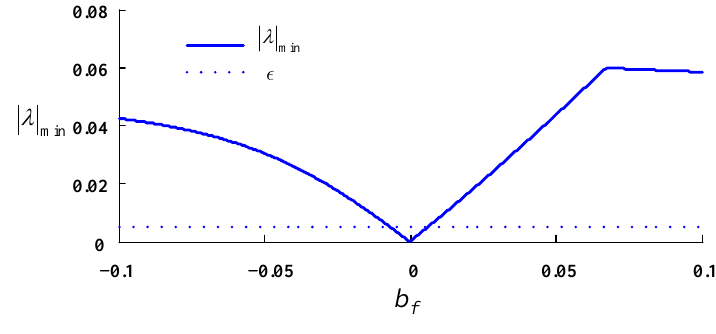
Figure 6. | λ | min with the change of b f